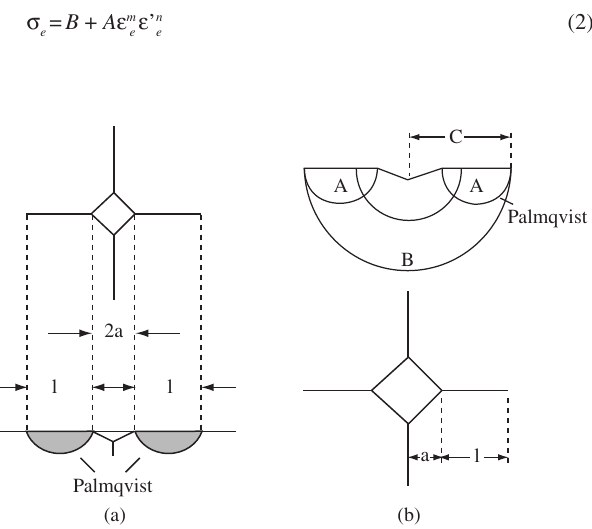
Figure 1. Models of crack nucleation and growth during Vickers indentation testing: a) Niihara 9 ; and b) Laugier 5 .